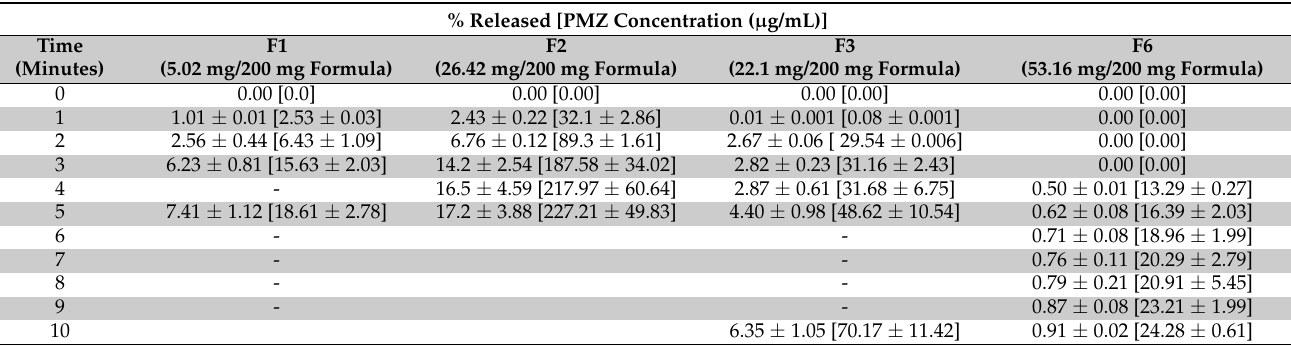
Table 6. Summary of the percentage cumulative release of PMZ from various formulas (200 mg of each formula added to 20 mL of artificial saliva); results are presented as the mean ± SD, n = 3.